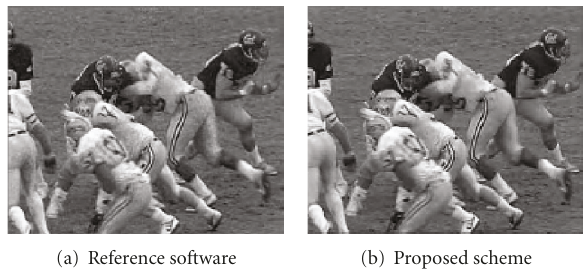
Figure 8: Decoded frames of